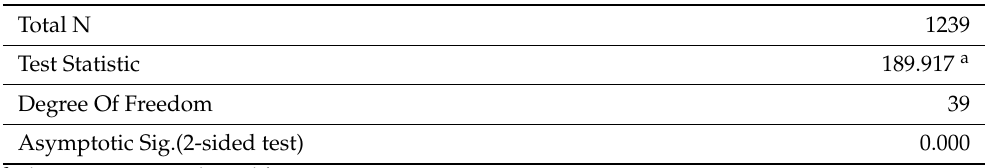
Table 7. Independent-Samples Kruskal–Wallis H Test Summary. The table shows the results of independent-samples Kruskal–Wallis H test between functionalisation groups’ viability scores. Total N Test Statistic Degree Of Freedom Asymptotic Sig.(2-sided